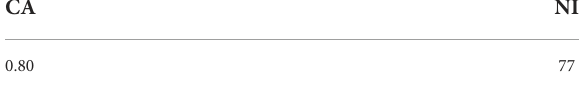
TABLE 2 Reliability